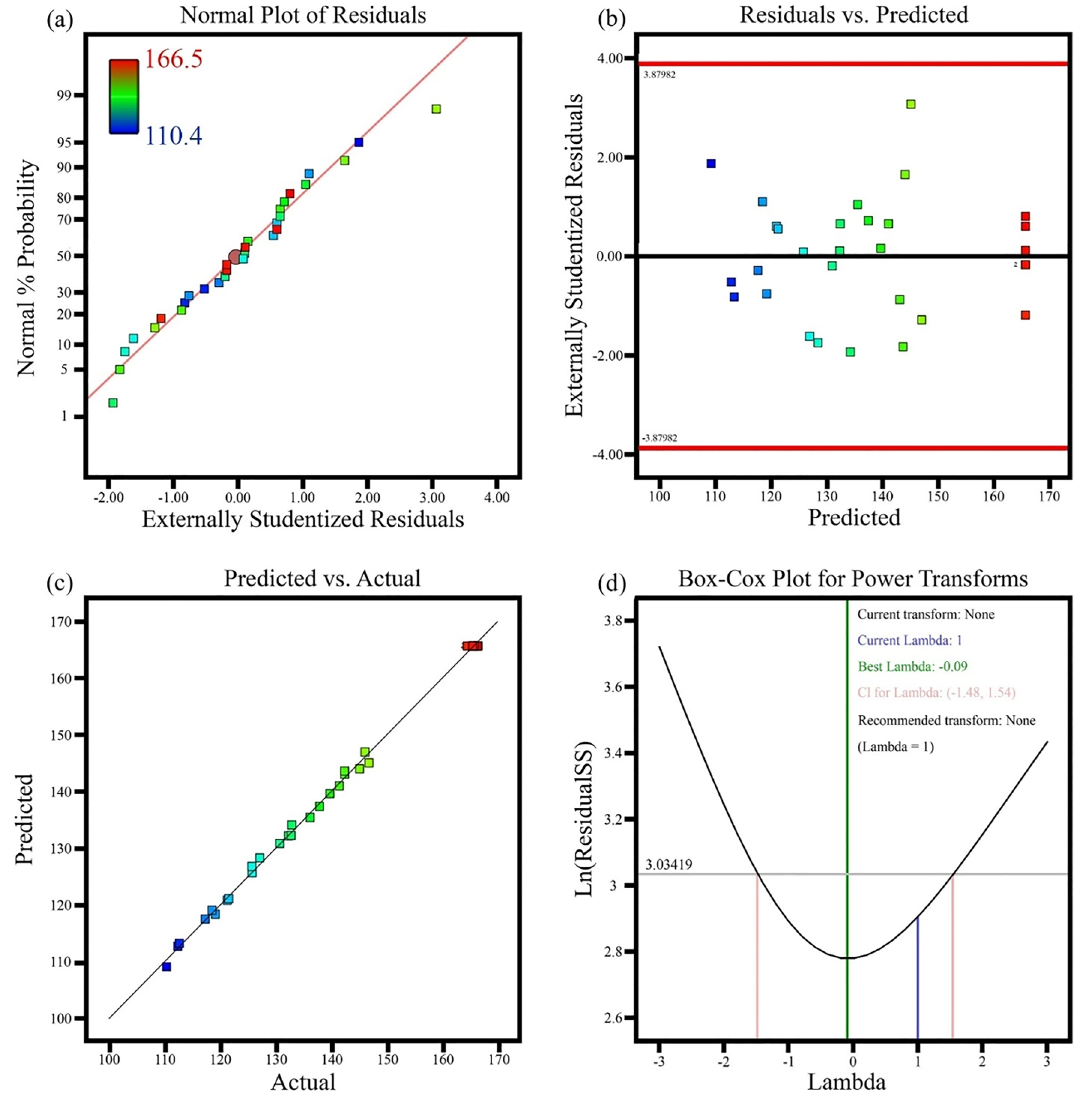
Figure 2. Diagnostics diagrams ( a ) normal probability, ( b ) residuals vs. predicted, ( c ) predicted vs. actual and ( d ) Box-Cox plot for power 95% confidence interval associated with the best amount of lambda. It is said that a model is qualified for the blue conversion line between the red lines and the green line on the conversion curve to form a black and white curve. The graph shows that the blue transition line between the green line and the red line shows that the model matches the experimental results. Influence of single variables on contact angle. Figure 3 shows the effect of the selected parameters on the contact angle. The graph follows a certain pattern for all parameters. With increasing water volume from 8 to 10, the con- tact angle gradually increased from 152.34° to 165.83°. Subsequently, with an increase from 10 to 12, the contact angle decreased from 165.83° to 158.45°. For the parameters of ethanol, ammonium hydroxide, and PDMS, the same changes occurred, i.e. the contact angle increased from − 1 to zero and decreased from zero to + 1. The effect of binary variables on the contact angle. In Fig. 4, the interaction and three-dimensional diagrams of the model are obtained to estimate the interaction between the variables and the contact angle, while the other variables are kept at their zero levels and the others change in the experimental range. In Fig. 4, as can be seen, the interaction of the binary parameters with each other is like the effect of the parameters individually. The difference between the interaction of the binary parameters with each other is in the angle between the two diagrams. The higher the angle of the two graphs, the greater the interaction, and if they are parallel, they have less or no interaction. According to the ANOVA table, the BC parameter is unacceptable, and the angle between the parameter BC is very small and they are almost parallel.